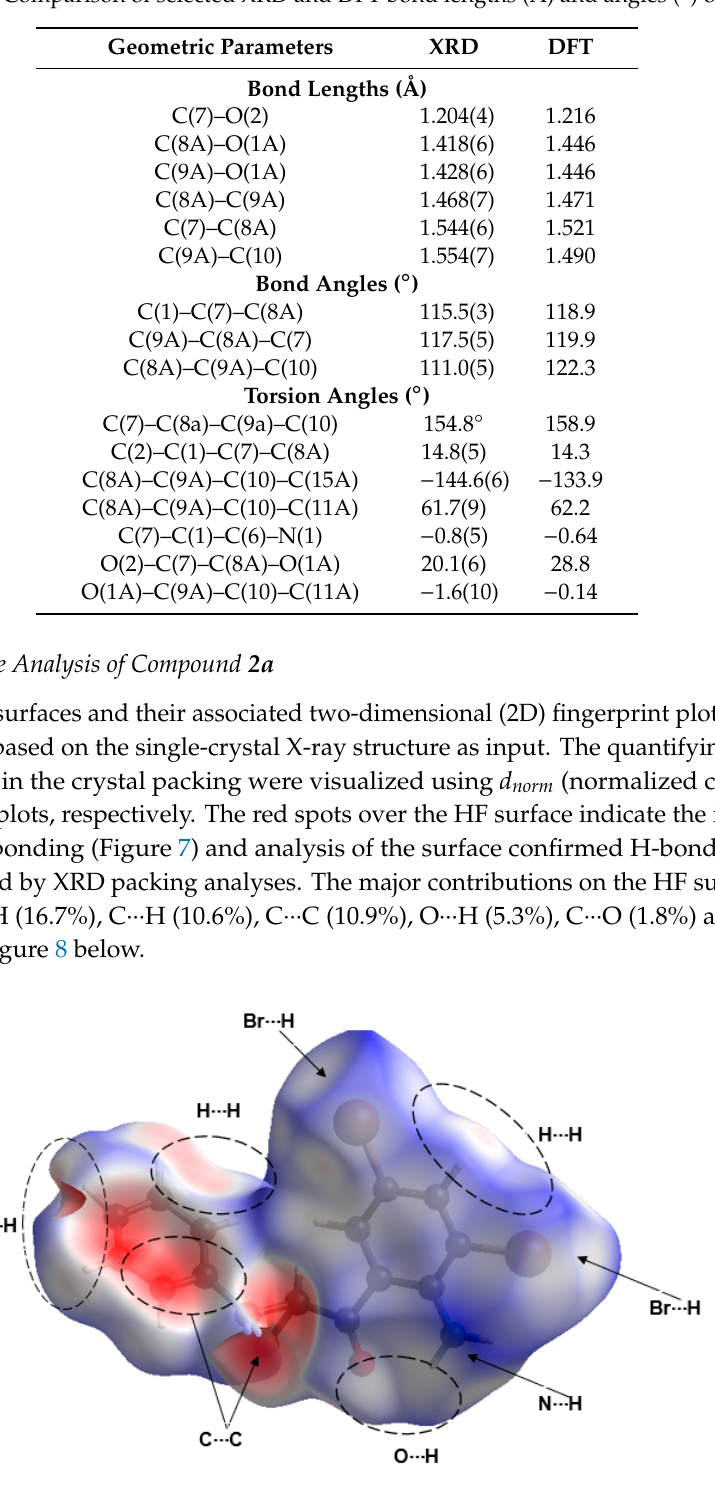
Figure 7. Hirshfeld surface of 2a mapped with the d norm function, and the regions of the most important intermolecular interactions are indicated by the dashed ovals and/or arrows.